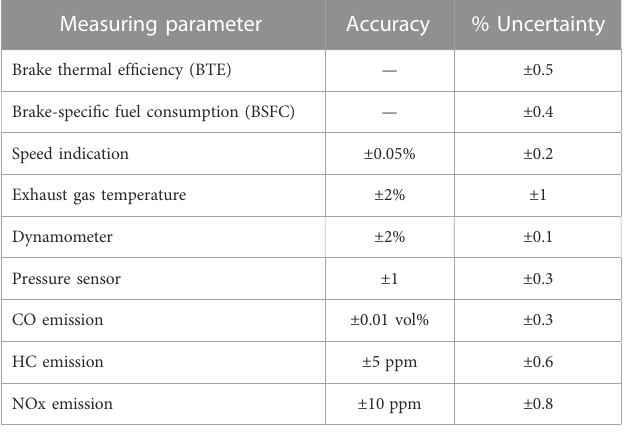
TABLE 4 Accuracy of different measurement instruments. Measuring parameter Accuracy